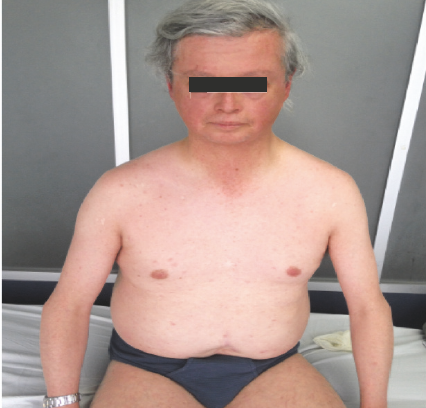
Figure 1: Patient’s face shows “bird-like facial appearance”, beak- shaped nose, scarce and gray hair, and eyebrows. Note thin upper limbs with decreased subcutaneous fat and truncal